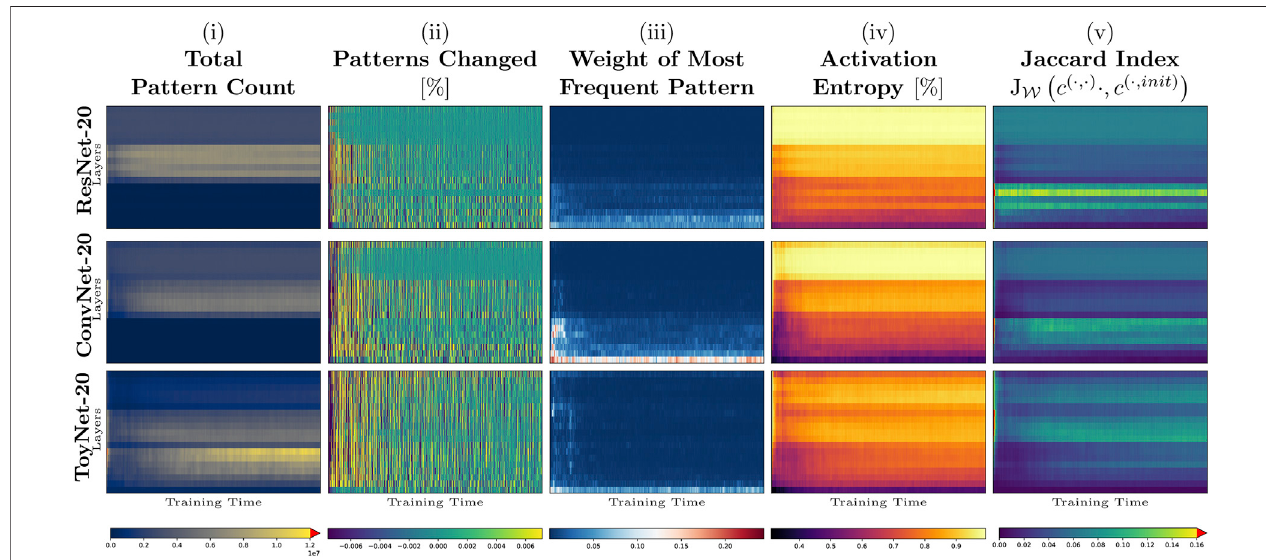
FIGURE1| EarlytrainingphaseofToyNet-20,ConvNet-20,andResNet-20( fi rst3,000iterations)onCIFAR-10.Thetoprowrepresentsthelastconvolutionallayer before the linear classi fi cation layer. The bottom row corresponds to the fi rst convolutional layer in each image. The images, from left to right, show: (A) the size of the activationpatternset,relativetothemaximumsizeseenduringtraining; (B) thechangeofsizeofthispatternset,truncatedforbettervisibility; (C) therelativefrequencyof the most frequent activation pattern; (D) the activation entropy; and (E) the weighted Jaccard similarity comparing the current activation patterns to those directly after network